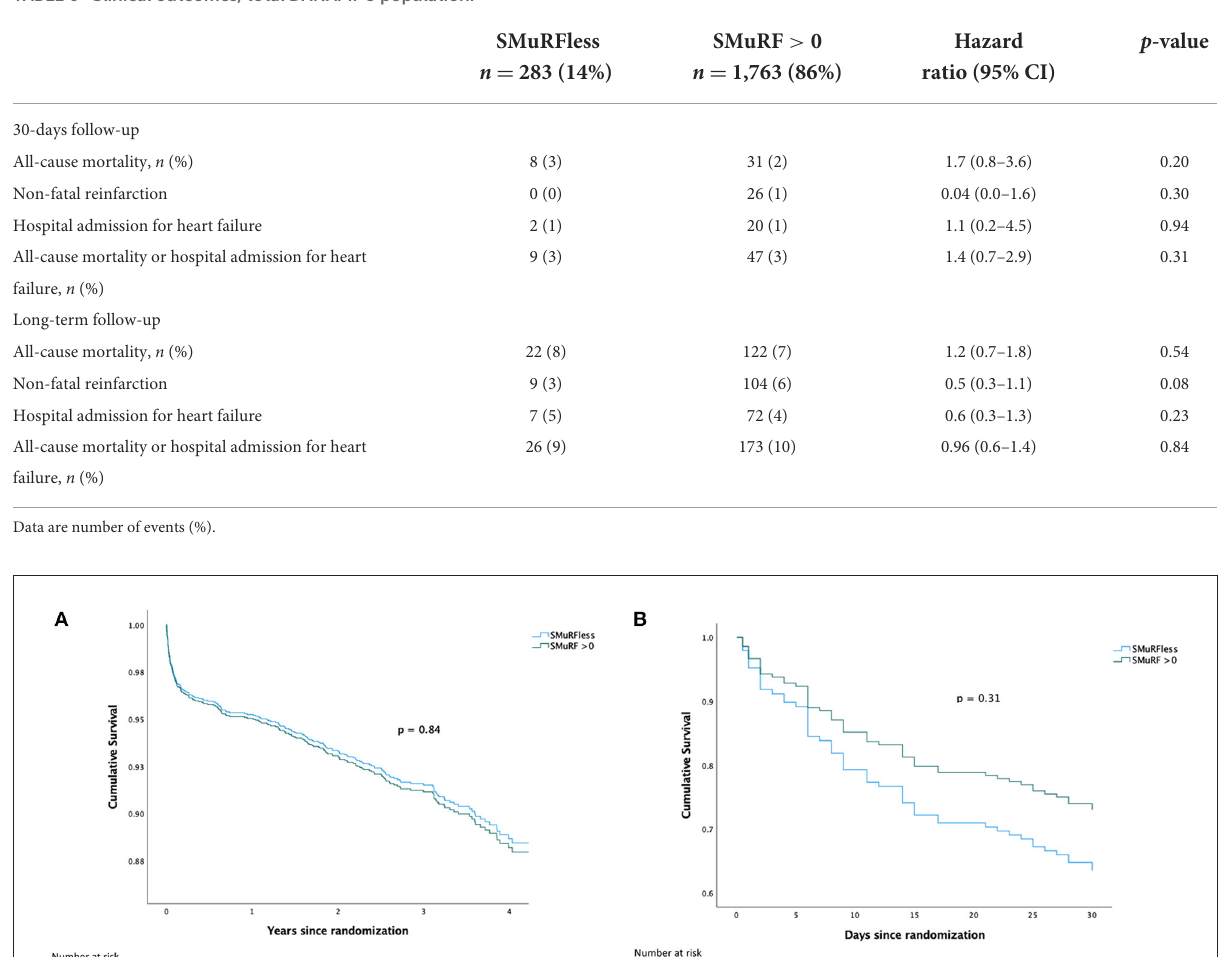
TABLE 6 Clinical outcomes, total DANAMI-3 population.